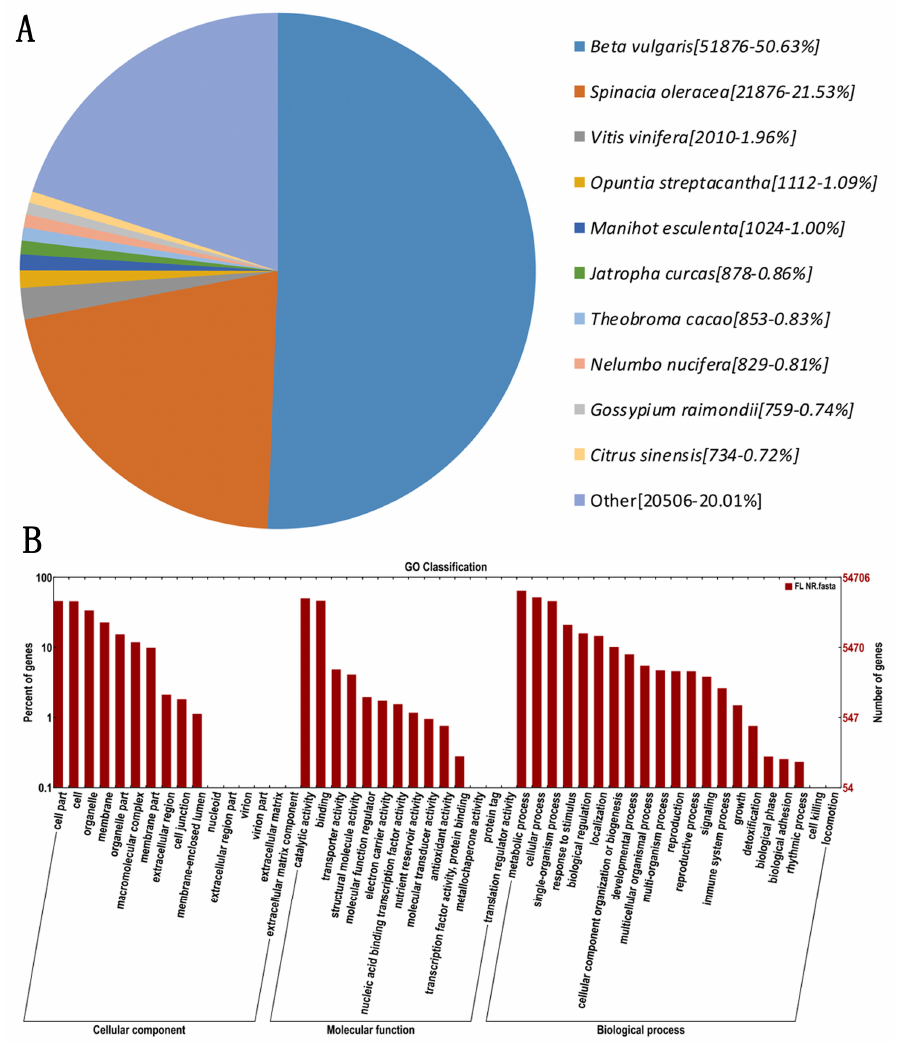
Figure 2. The distribution features of annotated genes. ( A ), Homologous species distribution of pitaya annotated in the NR database. ( B ), Gene Ontology (GO) functional annotation of pitaya genes. The x-axis represents GO categories, the y-axis (right) represents the number of genes, and the y-axis (left) represents the percentage of genes.